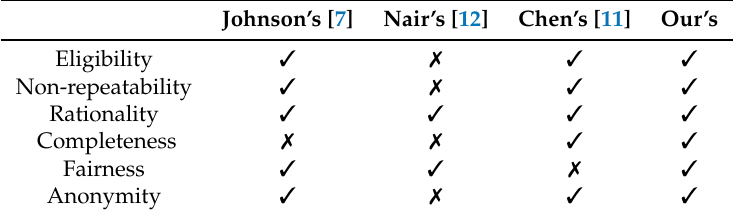
Table 5. Comparison of security